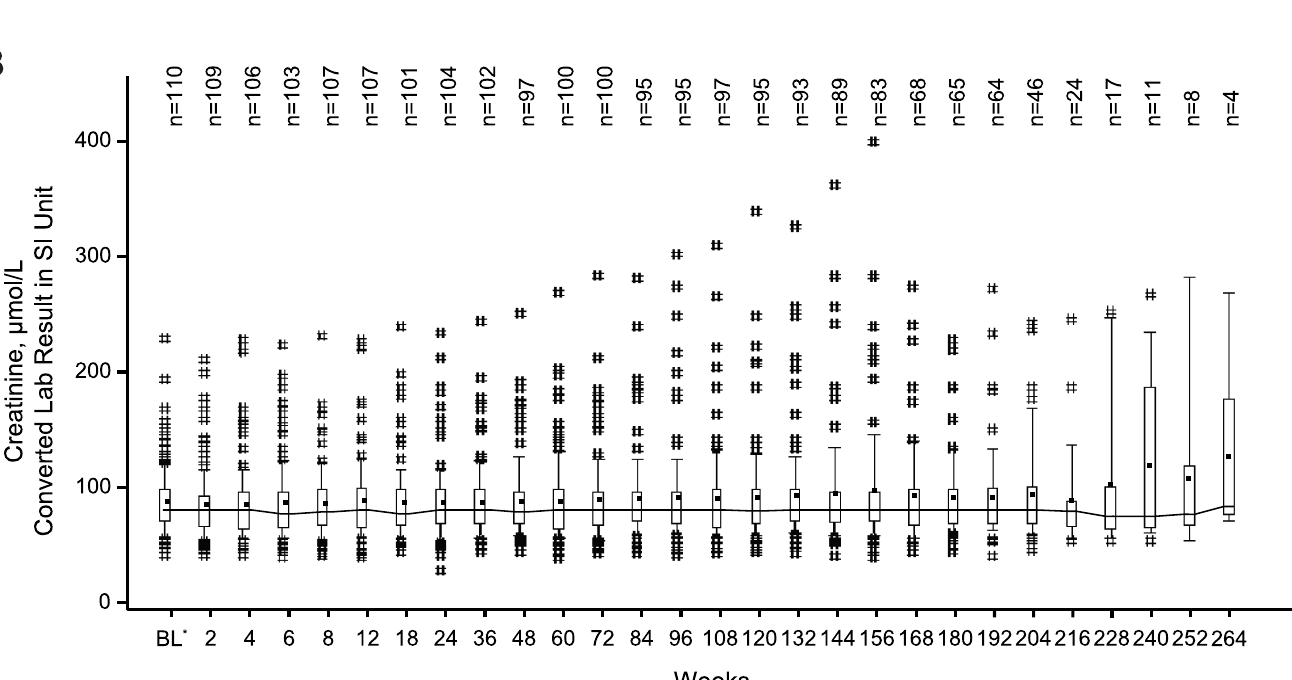
Fig 6. Median GFR (A) and creatinine (B) over time. Mediansare connectedby lines, means are displayedas dots. Boxes are drawn from P25 to P75. Whiskers extend from P10 to P90. # indicatesvalues that lie outside [P10, P90]. * Baselineassessment is the last performed before start of everolimus. Post-baseline laboratoryassessments performed at unplannedscheduleor more than 28 days after discontinuation of everolimus are not presented. Only results from central laboratoryare included.Abbreviations: BL = baseline;GFR = glomerularfiltration rate; P = percentile.